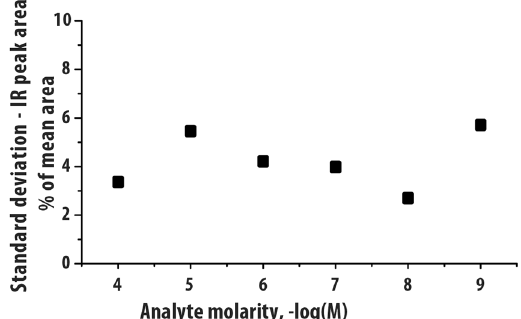
Figure 2. Standard deviation of the IR peak area as a percent of the mean value. Five repeated measurements over the 3500–3590 cm − 1 range for the protonated amino acid tryptophan, a well understood system studied previously 23 , are presented. The standard deviation of IR peak area over the range of 100 μ M – 1 nM has a maximum of